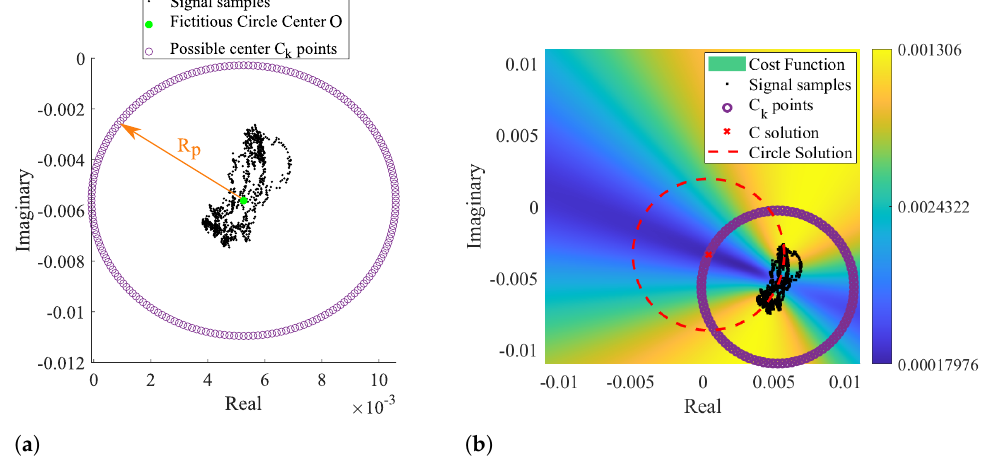
Figure 8. Illustration of the novel arc fitting method: ( a ) definition of the possible C k solutions, ( b ) cost function result with the selected C